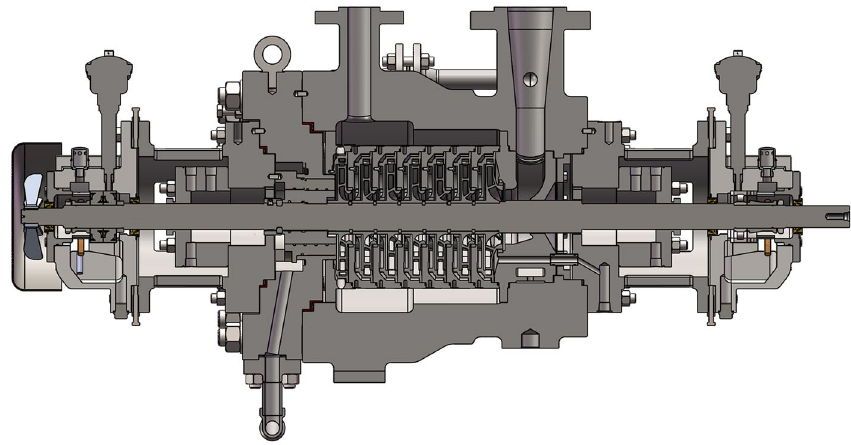
Figure 1. Inside of the 7-stage double-shell high-pressure water injection centrifugal pump.